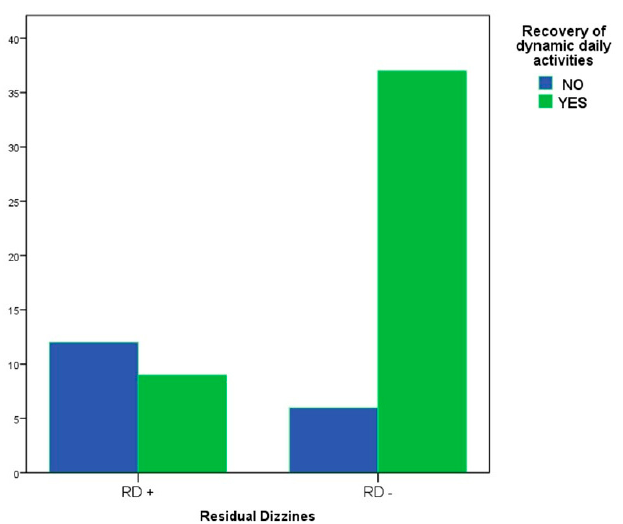
Figure 3. Correlation between residual dizziness and recovery of dynamic daily activities. RD+, patients reporting residual dizziness; RD − , patients free from residual dizziness.